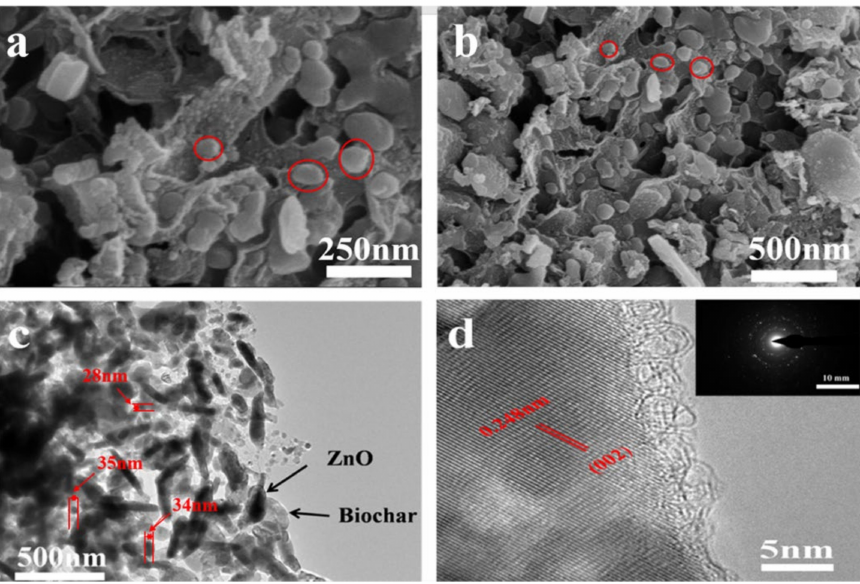
Figure 1. ( a , b ) SEM images of ZnO@BC photocatalyst; ( c , d ) TEM images of ZnO@BC photocatalyst.